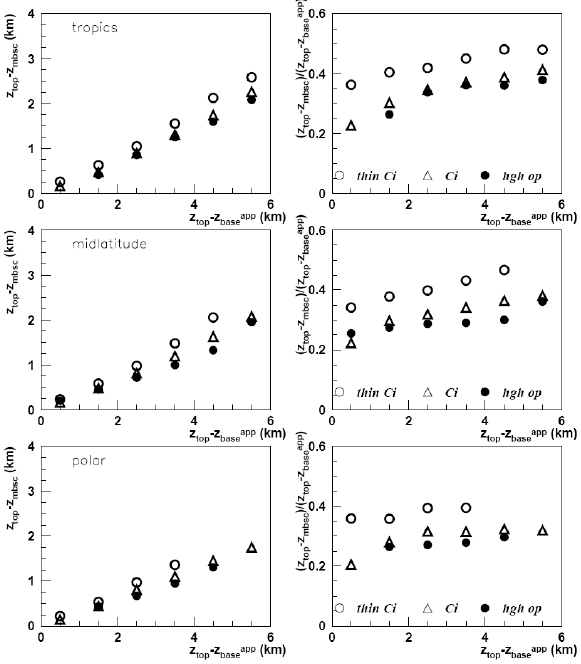
Figure 13: Average difference between cloud top and ‘radiative’ cloud height (left panels) and average Fig. 13. Average difference between cloud top and “radiative” cloud difference relative to ‘apparent’ cloud geometrical thickness (right panels) as a function of ‘apparent’ height (left panels) and average difference relative to “apparent” cloud geometrical thickness, separately for high opaque clouds (full circles), cirrus (open triangles) and cloud geometrical thickness (right panels) as a function of “appar- thin cirrus (open circles) and for three different latitude bands: 30°N-30°S (upper panels), 30°-60° ent” cloud geometrical thickness, separately for high opaque clouds (middle panels) and 60°-90° (lower panels). (full circles), cirrus (open triangles) and thin cirrus (open circles) and for three different latitude bands: 30 ◦ N–30 ◦ S (upper panels), 30 ◦ –60 ◦ (middle panels) and 60 ◦ –90 ◦ (lower 44